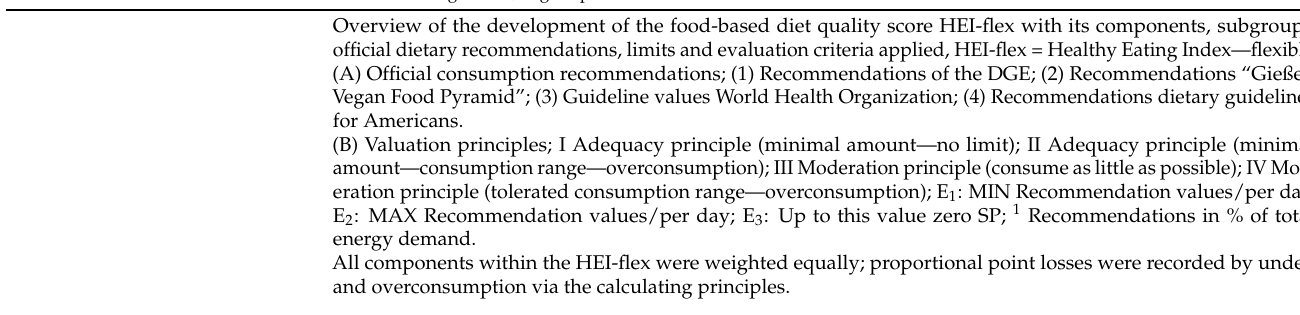
Solid fats (butter, margarine, vegetable cooking fat, animal fat), spreads and vegetable fats, plant-based alternatives like vegetarian/vegan spreads